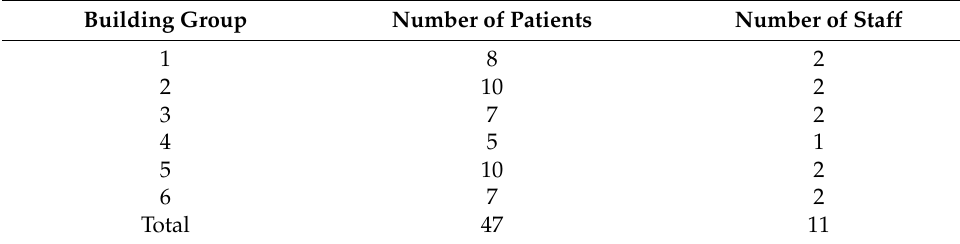
Figure 2. Surveyed buildings: ( a ) outside view of the medico-social buildings and ( b ) plan of the buildings. Table 1. Distribution of patients and staff in the